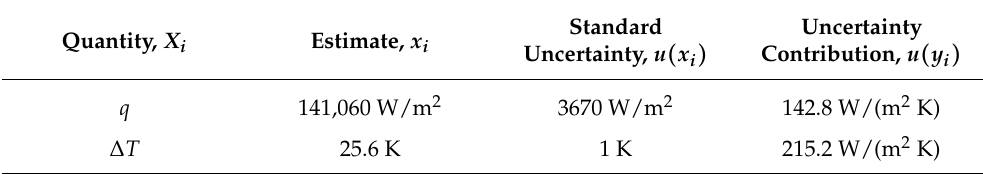
Table 5. Uncertainty budget for